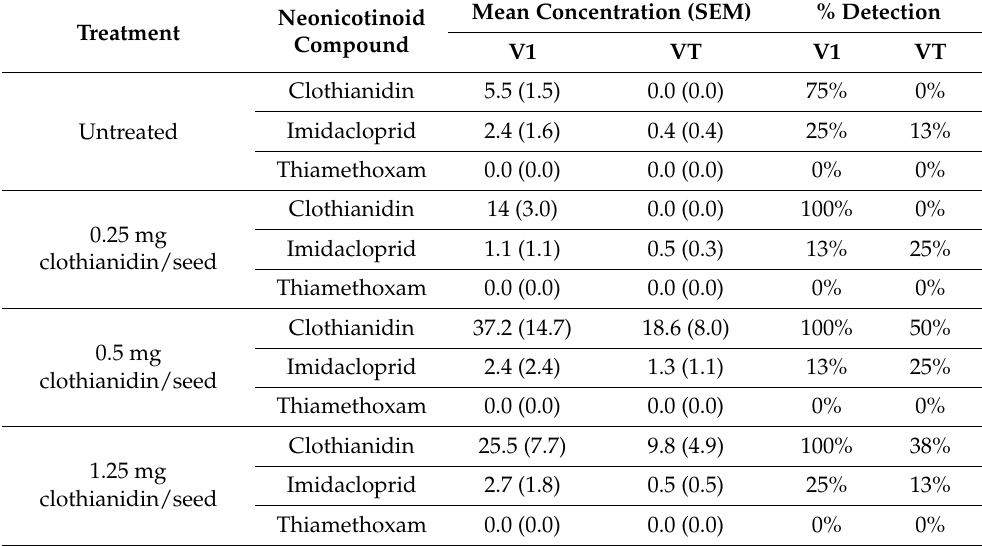
Table 4. Mean concentrations (ng/g) and percent detection of neonicotinoids detected in soil from corn plots shortly after emergence (V1) and at early tasseling (VT) across all locations.